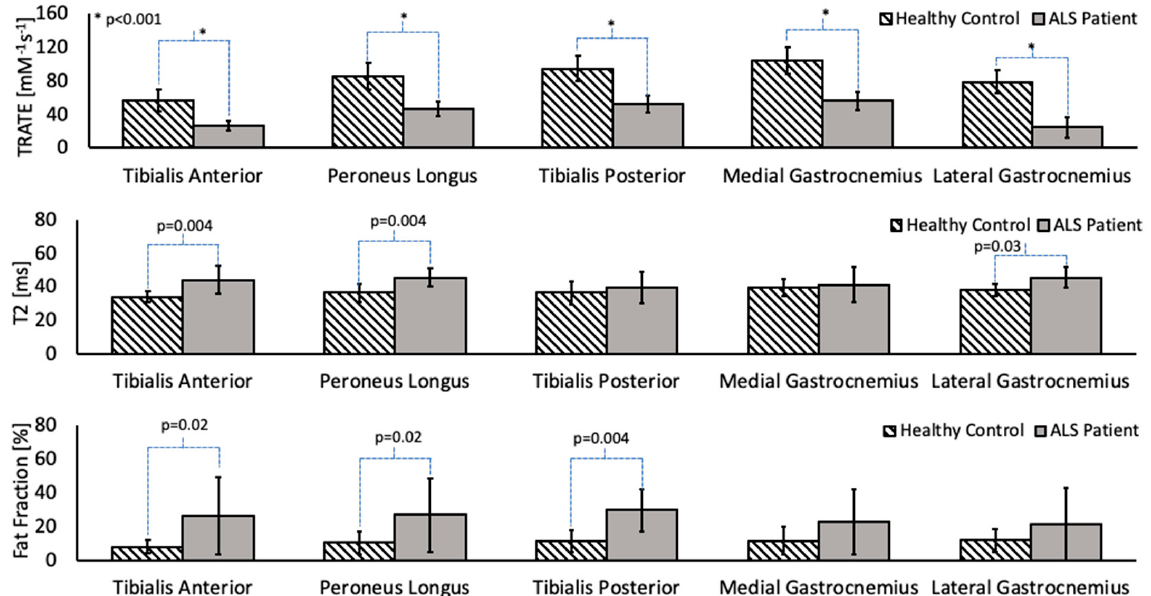
Figure 3. Group-wise analysis of TRATE, fat fraction and T2 values in cohorts of ALS and healthy subjects. TRATE was the only parameter to show statistically significant ( p < 0.05) differences between patients and controls across all muscles